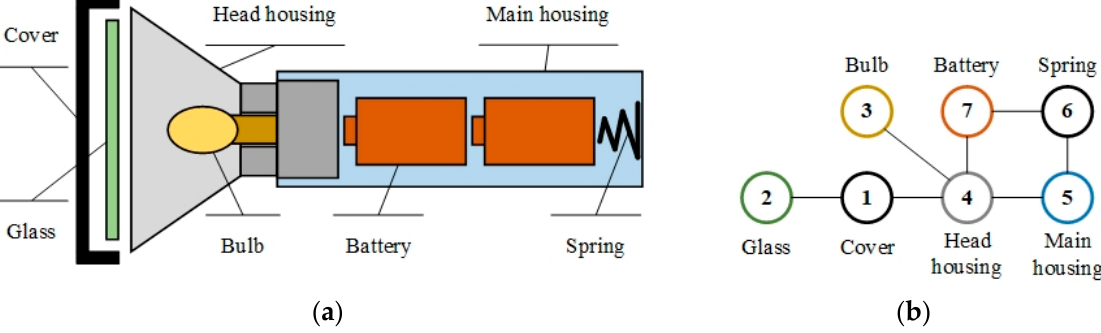
Figure 1. An example of a product: ( a ) a flashlight [45] and ( b ) the connection diagram of the flashlight.